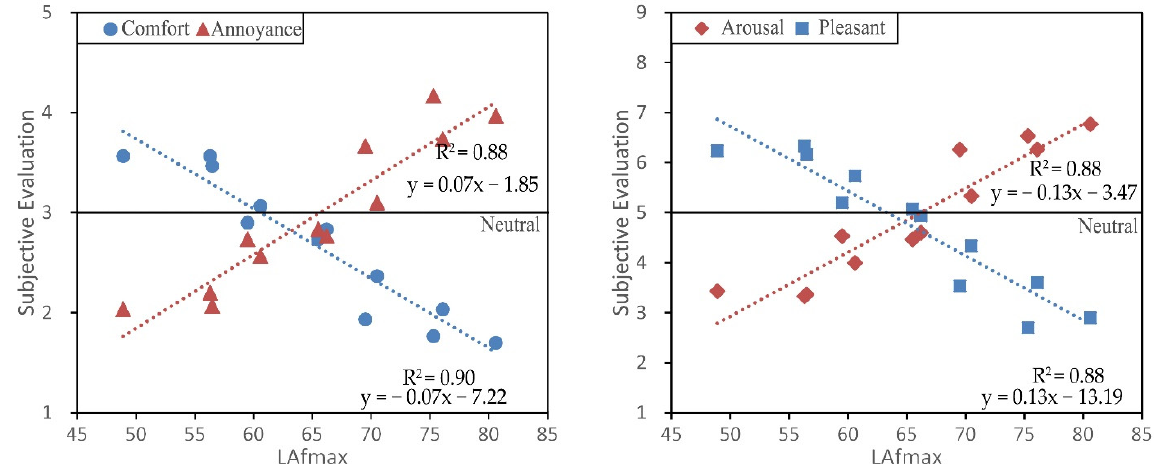
Figure 6. Effect of maximum sound level on psychological responses.